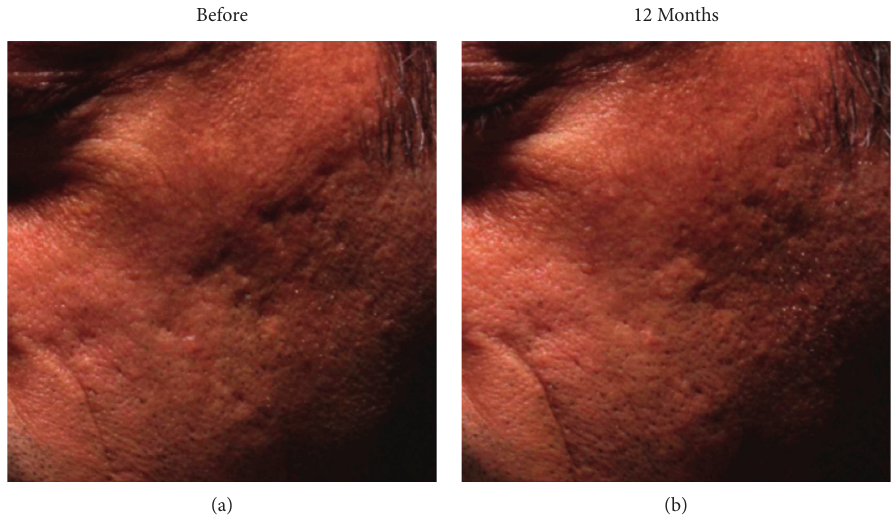
Figure 7: (a). Before and (b). 12 months after treatment of sectional scars using Bellafill ® (Suneve Medical, San Diego, CA), significant recovery of scars can be observed in the cheek